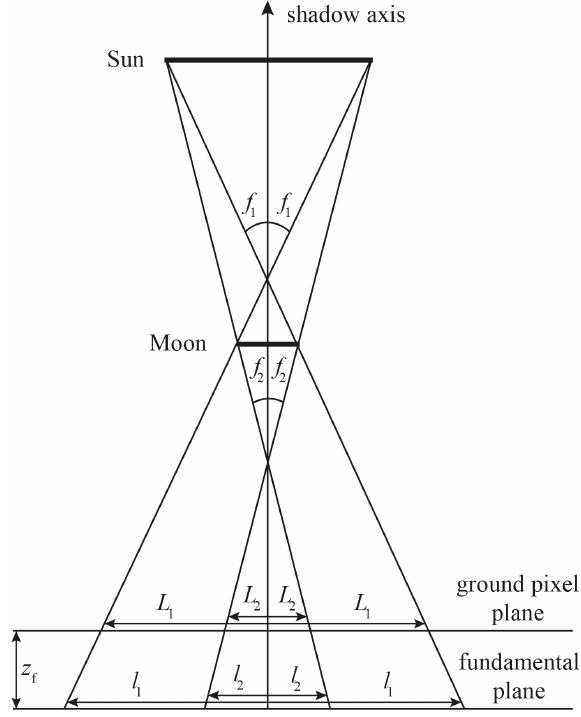
Figure A2. Definition of l 1 , l 2 , L 1 , L 2 , f 1 , and f 2 .